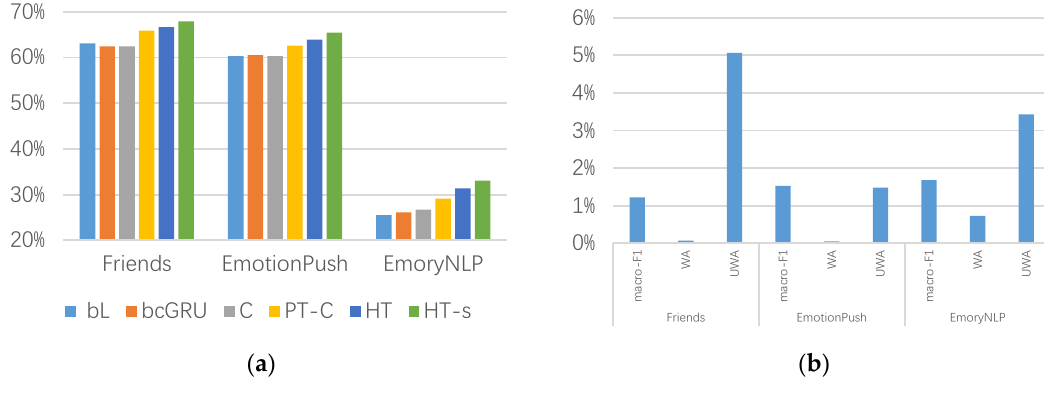
Figure 5. ( a ) The 𝑀𝑎𝑐𝑟𝑜 − 𝐹1 of several excellent methods. bL: bcLSTM + , bG: bcGRU, C: CoDE 𝑚𝑖𝑑 ,PT-C: PT − CoDE 𝑚𝑖𝑑 , HT: HiTransformer, HT-s: HiTransformer-s; ( b ) Description of the difference between the results of HiTransformer-s and HiTransformer applied to three datasets.